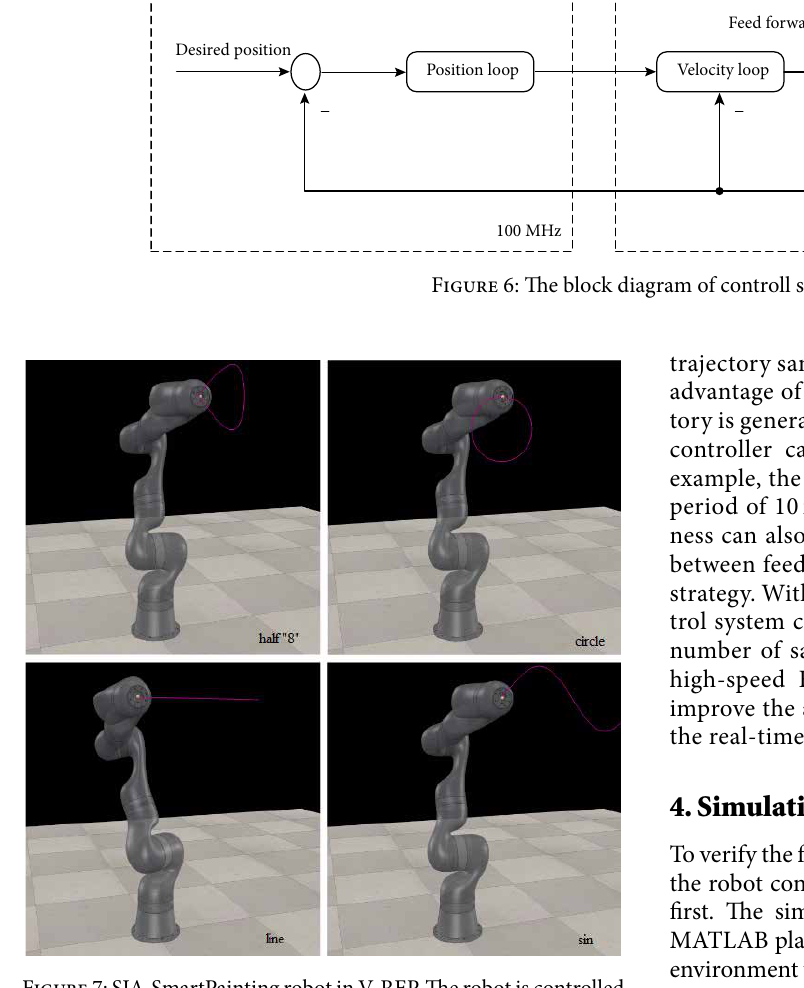
Figure 7: SIA-SmartPainting robot in V-REP. The robot is controlled to reproduce the pink end-effector